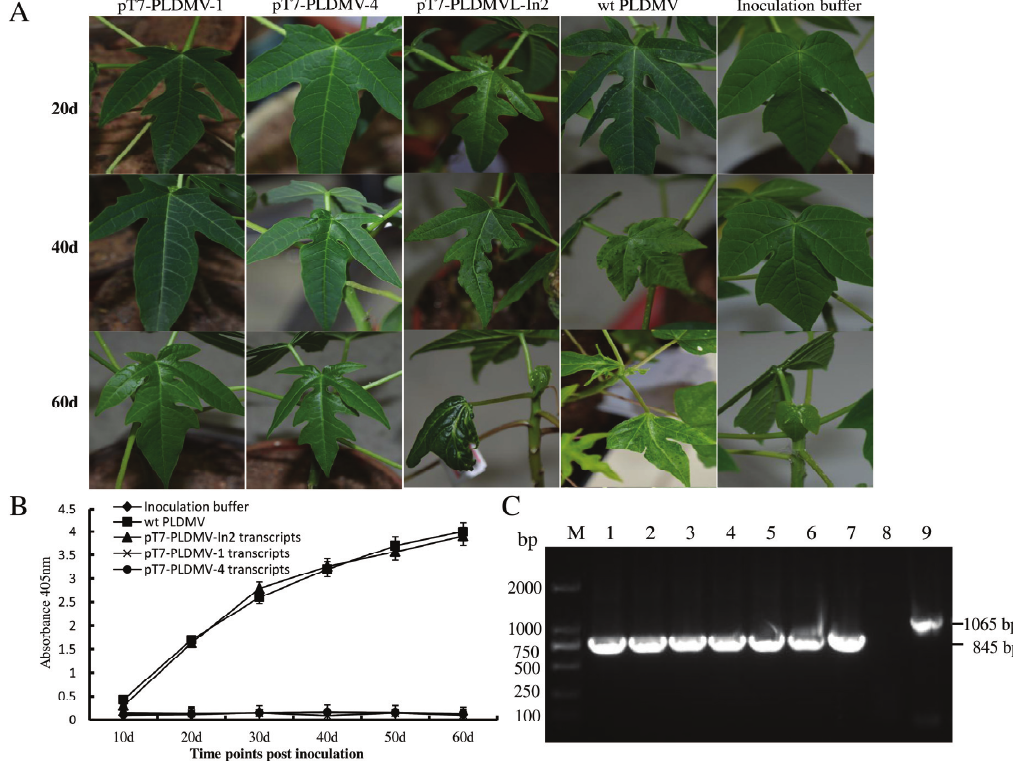
Figure 2. Symptoms and PLDMV detection in papaya plants inoculated with pT7-PLDMV and pT7-PLDMV-In2 transcripts. ( A ) Systemically infected leaves showed typical mosaic on leaves at 20 dpi, and developed severe distortion on leaves similar to those caused by the wild-type PLDMV at 40 and 60 dpi, while plants inoculated with pT7-PLDMV-1 transcripts containing one non-sense- or pT7-PLDMV-4-containing deletion mutation showed no symptoms; ( B ) Accumulation of PLDMV in the upper non-inoculated leaves of 10 papaya plants inoculated with pT7-PLDMV-1, pT7-PLDMV-4, or pT7-PLDMV-In2 transcripts at various times post-inoculation by ID-ELISA. The positive controls were inoculated with papaya sap known to be infected with PLDMV (wt PLDMV); negative controls were inoculated with inoculation buffer; ( C ) Detection of PLDMV RNA in systemically infected leaves and identification of the splicing of intron 2 from the progeny viruses from the pT7-PLDMV-In2-inoculated plants at 60 dpi by RT-PCR. Lane M: DNA Marker; 1: RT-PCR products